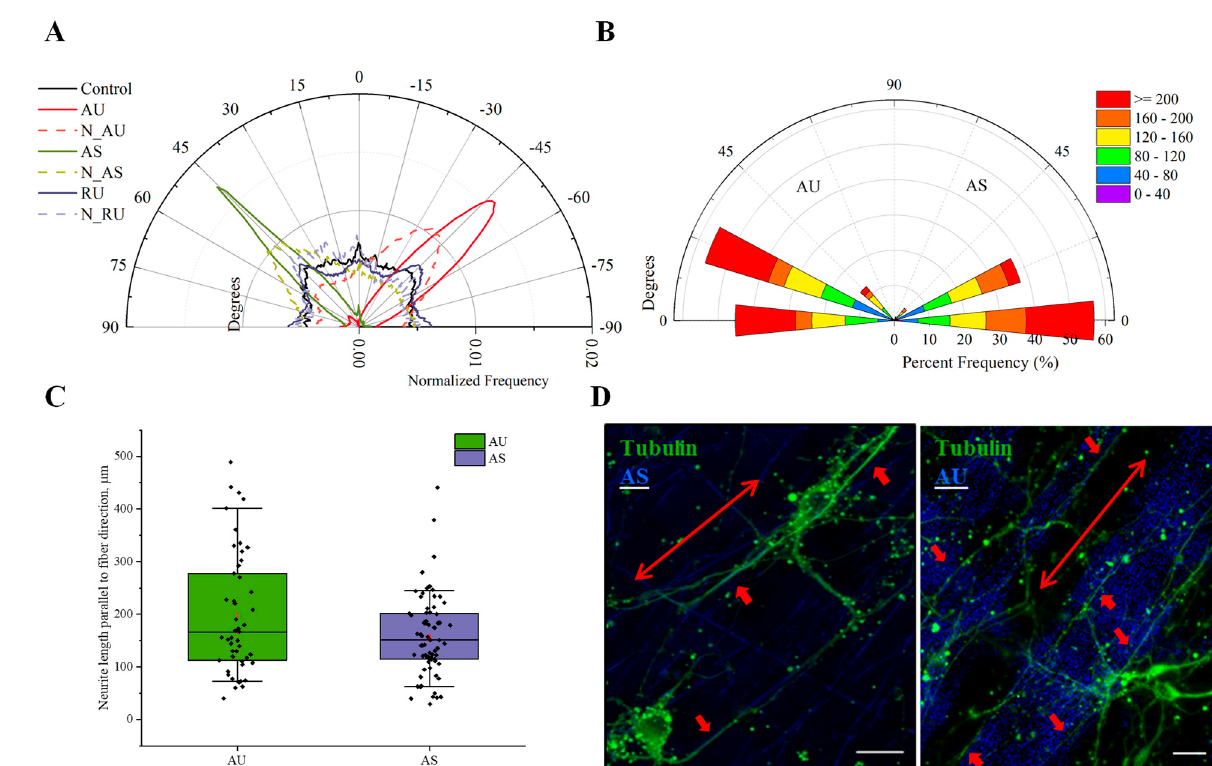
Figure 6. The effect of fiber diameter on nanotopology-mediate guidance of neurites. ( A ) Angular distribution of neurites on control and RU, AU, and AS fibers; ( B ) rose wind plot of the number of neurites of a given length growing at a given angle to the fiber per bin. Each radial distance is indicated by the color and the size of each color represents the percentage of neurite frequency at that distance; ( C )—average length of neurite parallel to the fiber direction. The dots correspond to the obtained values; boxes and bars correspond to 25–75% and 10–90% percentiles, consequently; horizontal lines represent median values; ( D ) representative confocal images of neurons cultivated on AU and AS fibers (small arrows—neurite parallel to the fiber, large arrows—fiber direction). Scale bar—20 μ m.